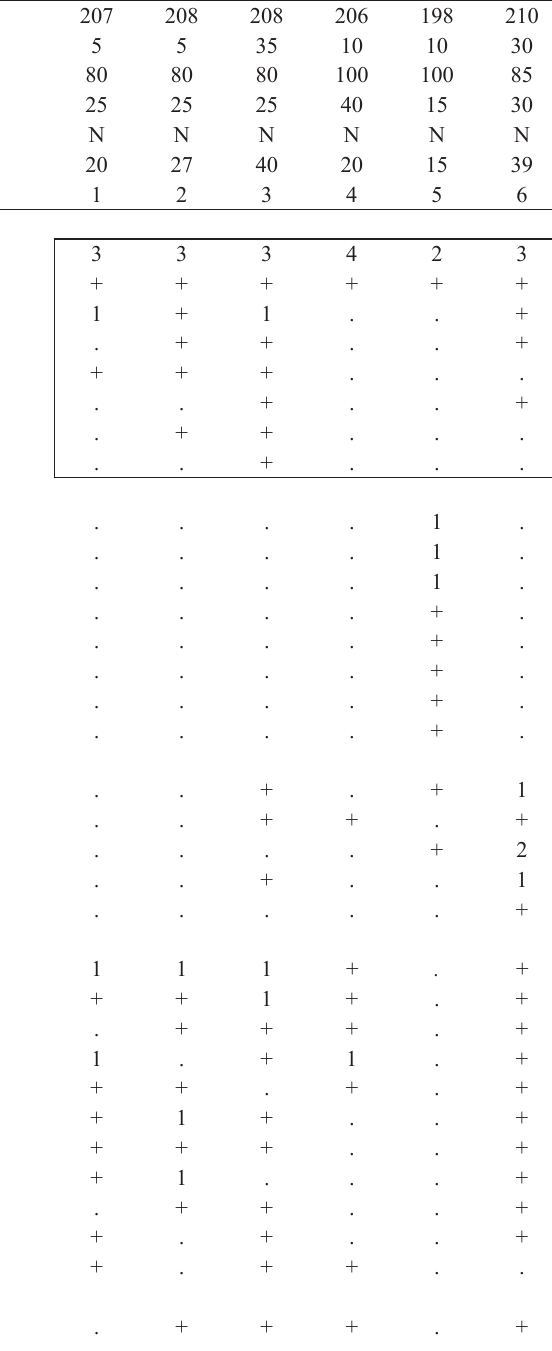
Table 2. Alchemillo alpinae-Salicetum breviserratae ass. nova ( Salicion herbaceae, Salicetalia herbaceae, Salicetea herbaceae ) Altitude (1=10 m